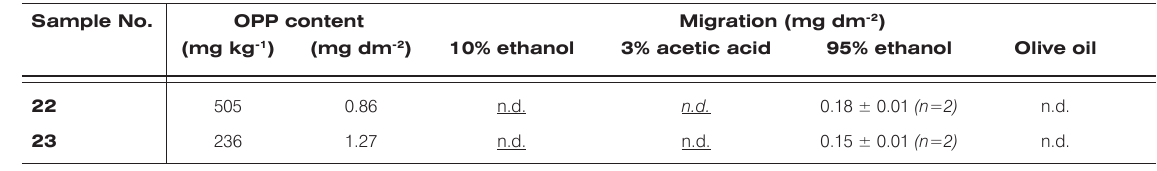
Table 3. Migration of OPP from paper packaging materials coated with low density polyethylene into 3% acetic acid, 10% and 95% ethanol and olive oil after 10 days at 40 °C. Sample